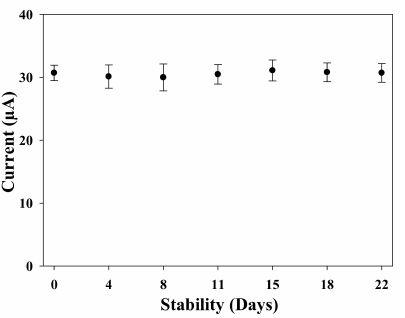
Figure 7. Time stability test of the MIP electrochemical